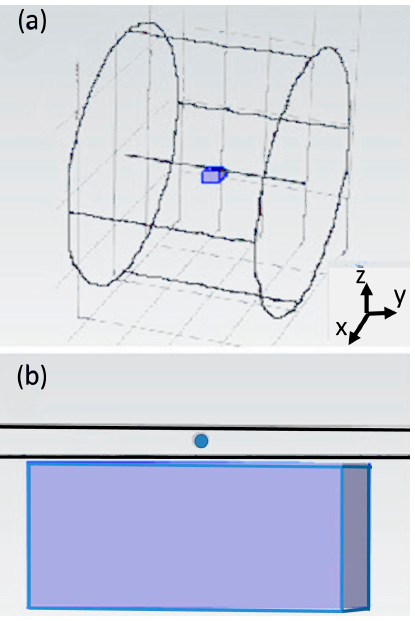
Figure A1. Geometry of simulation of a rotating quark nugget. ( a ) The overall geometry of the simulation shows the 20 m radius conducting boundary with the cylindrical rotating coordinate system centered on the axis and the 4 × 4 × 2 m thick slab of simulated peat. ( b ) Close up of the peat slab with its top surface located 0.3 m below the center of the 0.1 m radius, spherical magnet simulating the quark nugget, which is inside the cylindrical 0.2 m radius rotating coordinate system.